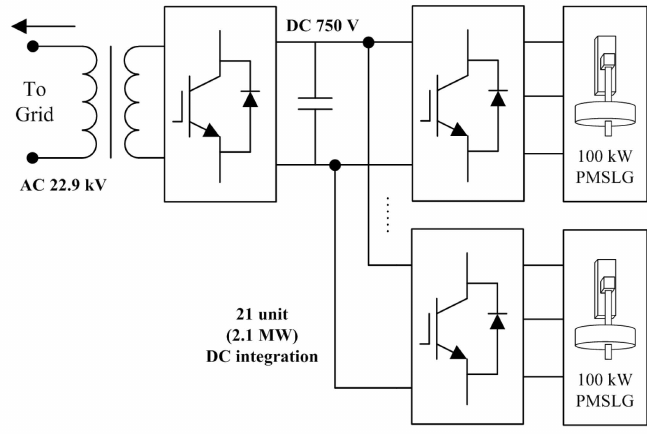
Figure 3. Low voltage DC system for wave